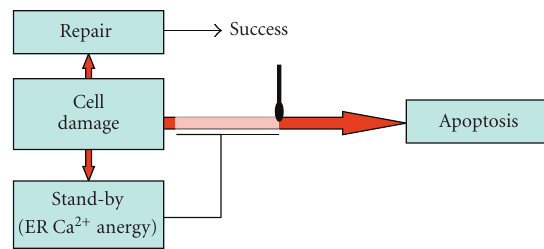
Figure 3: Temporary ER Ca 2+ anergy avoid loss of repairable cells. Cell damage elicits repair and apoptosis as well as standby periods (red arrows). ER Ca 2+ anergy is temporarily achieved via ADP- ribosylation of GAPDH, glycolysis block and starvation of Ca 2+ - ATPases, and hampers apoptotic signal transduction at the ER signaling stage. After resumption of glycolysis and ER Ca 2+ activity, the apoptotic signal is allowed to proceed, unless successful repair has occurred in the meantime.